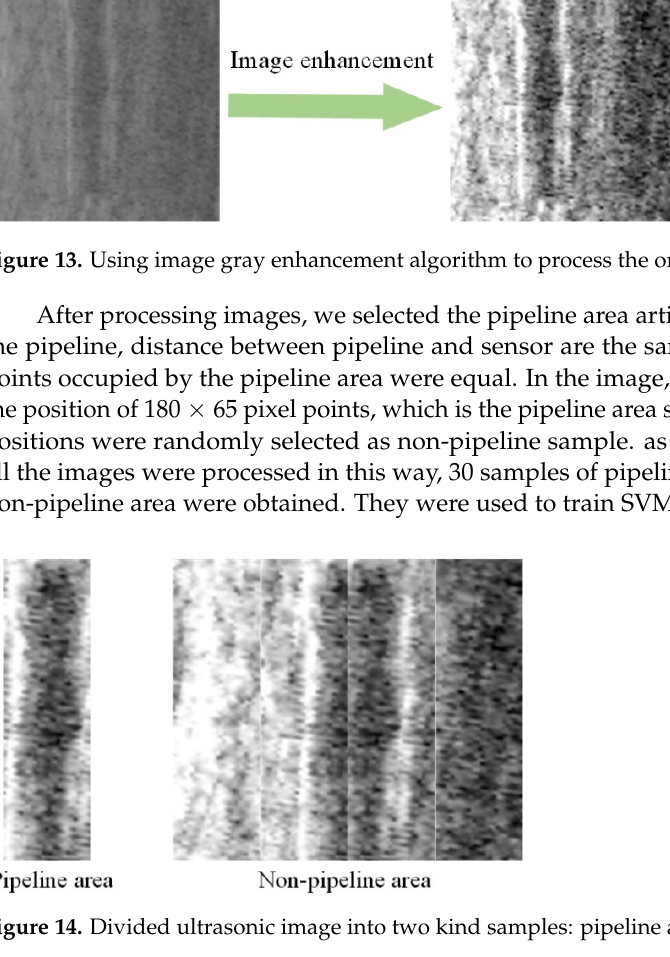
Table 1. Characteristic parameters of HOG algorithm.